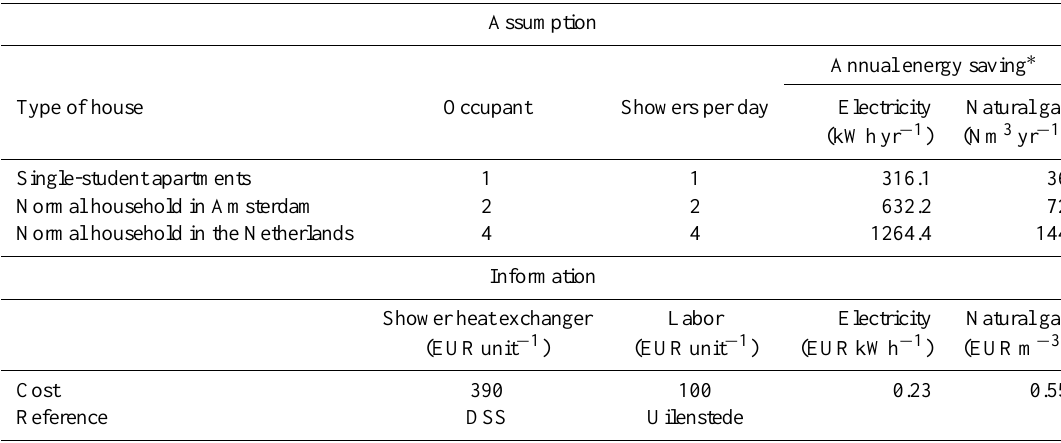
Table 4. Assumptions and information for payback period